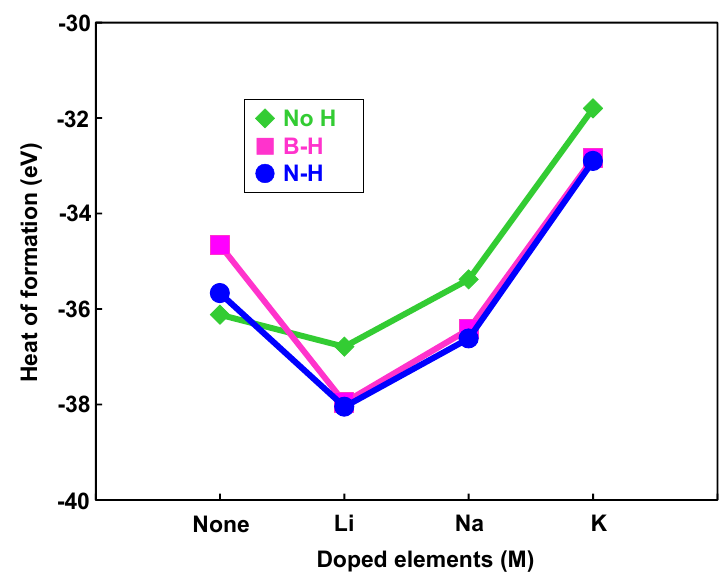
Figure 9. Heats of formation of hydrogenation for M@B 24 N 24 clusters by endohedral elements.